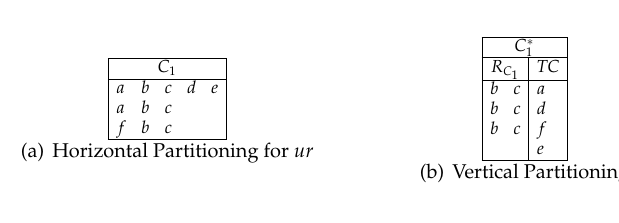
Figure 3. Example of a utility driven